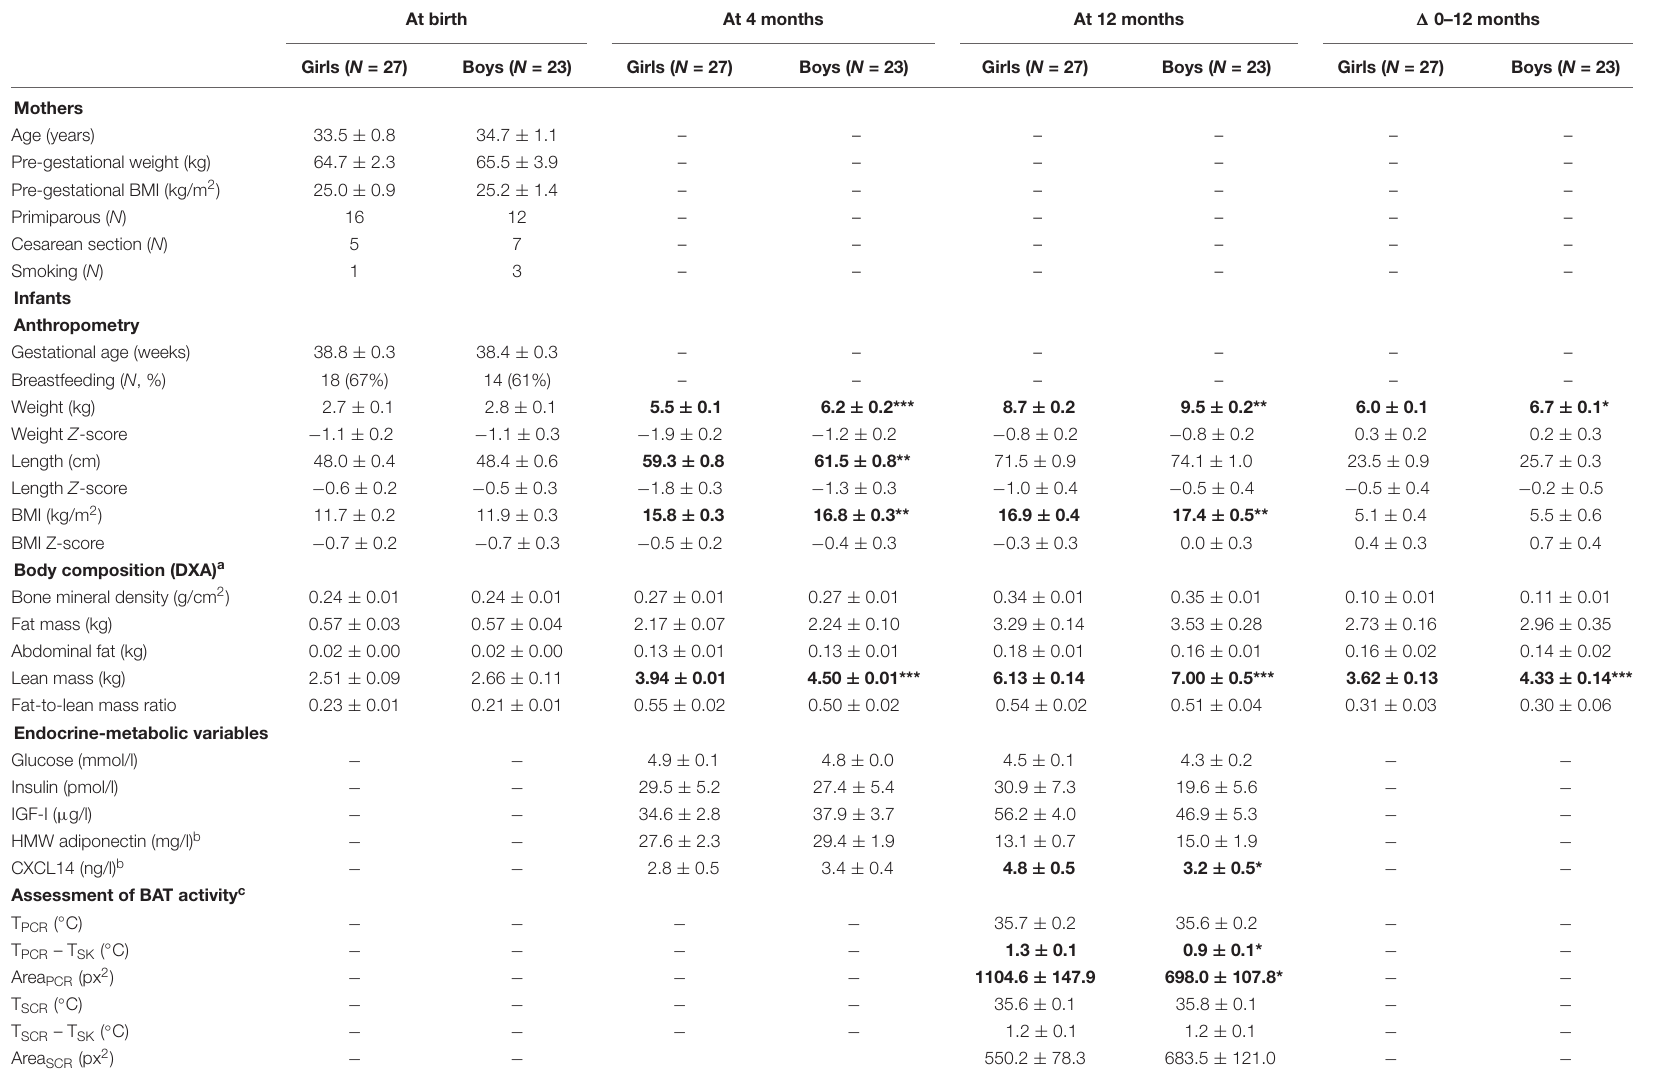
TABLE 1 | Maternal data and longitudinal infant data at birth and at age 4 and 12